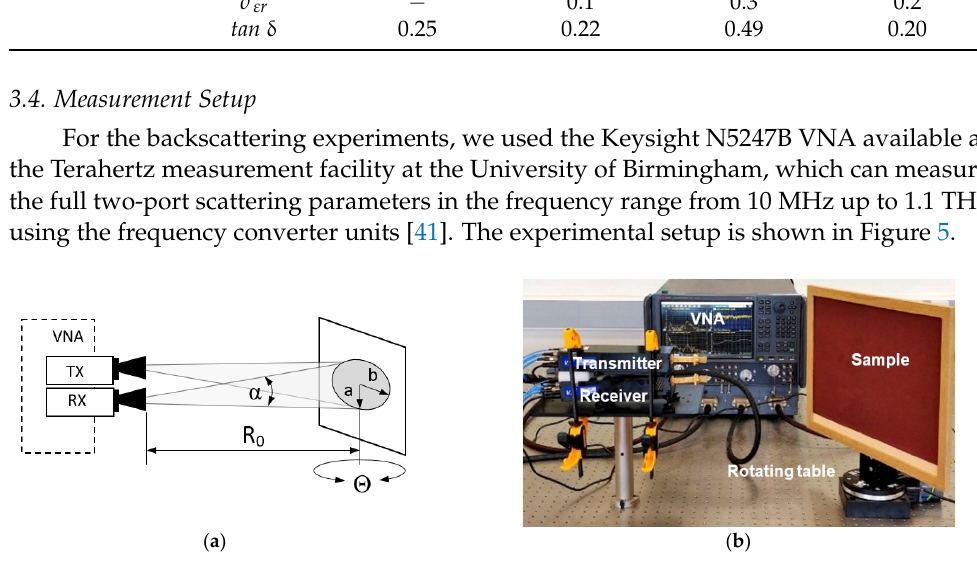
Figure 5. Experimental setup configuration ( a ) schematic setup, ( b ) actual setup.